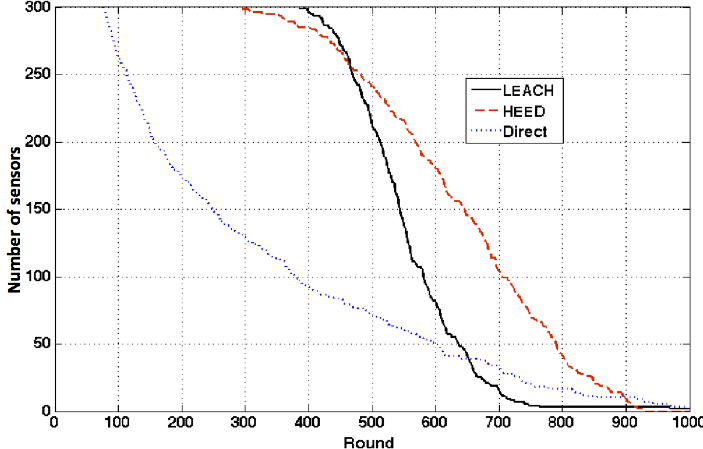
Figure 2. Number of sensors still alive in the